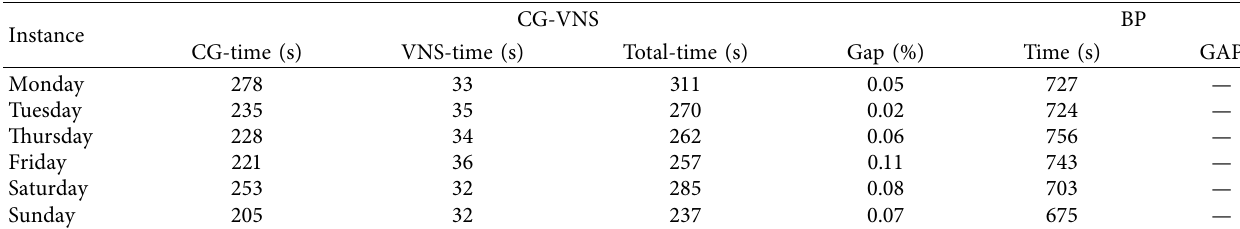
Table 5: CG-VNS vs BP.